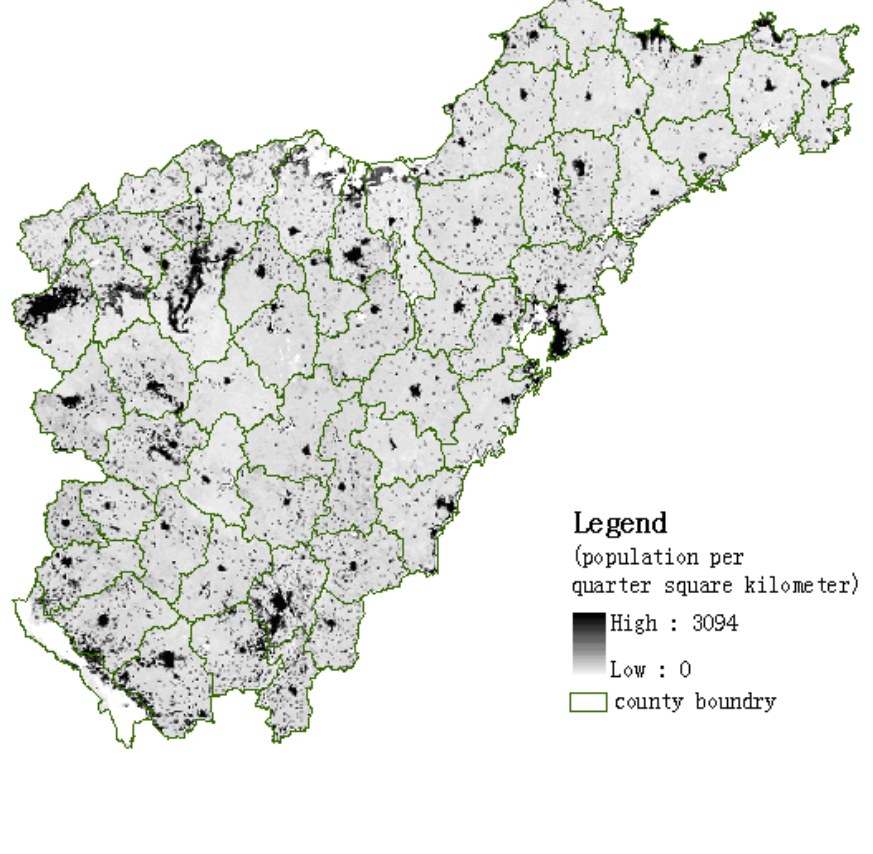
Figure 5. 500 m by 500 m gridded population data of Shandong Peninsula in